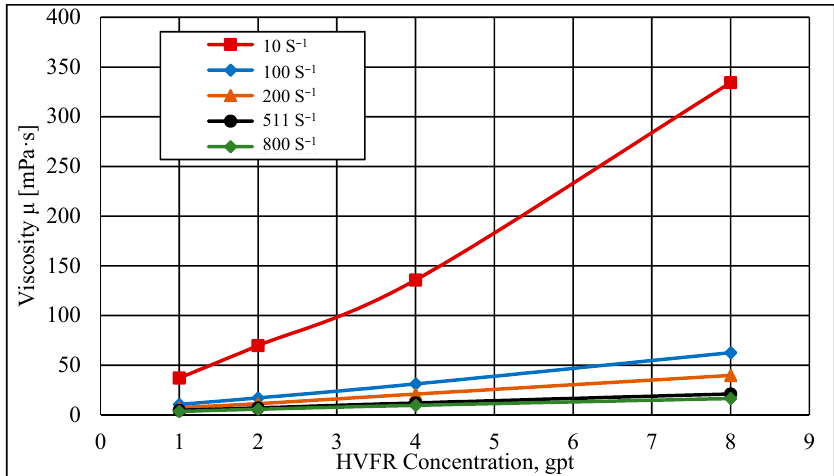
Figure 4. Viscosity curve of HVFR concentrations at different shear rates.